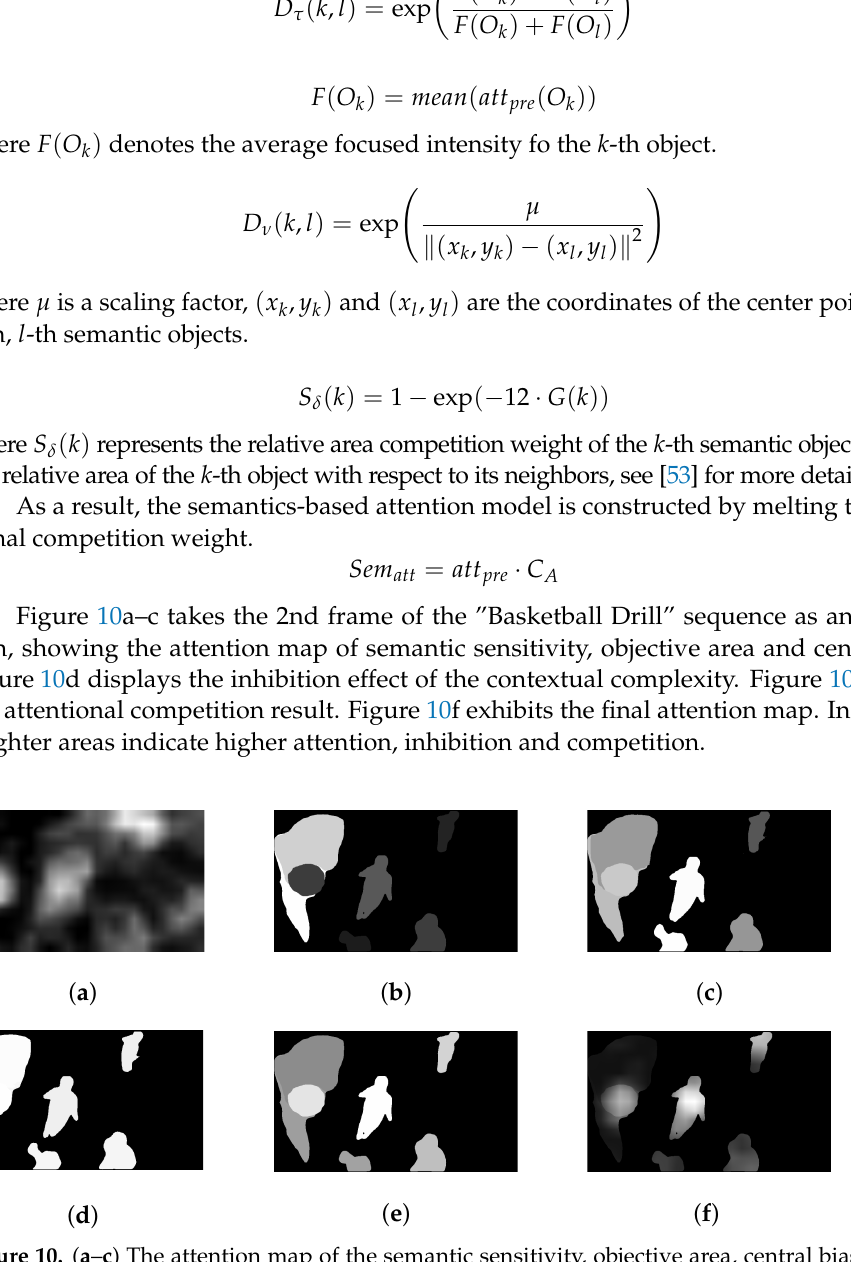
Figure 10. ( a – c ) The attention map of the semantic sensitivity, objective area, central bias; ( d ) The inhibition effect of the contextual complexity; ( e ) The attentional competition map; ( f ) The semantic attention